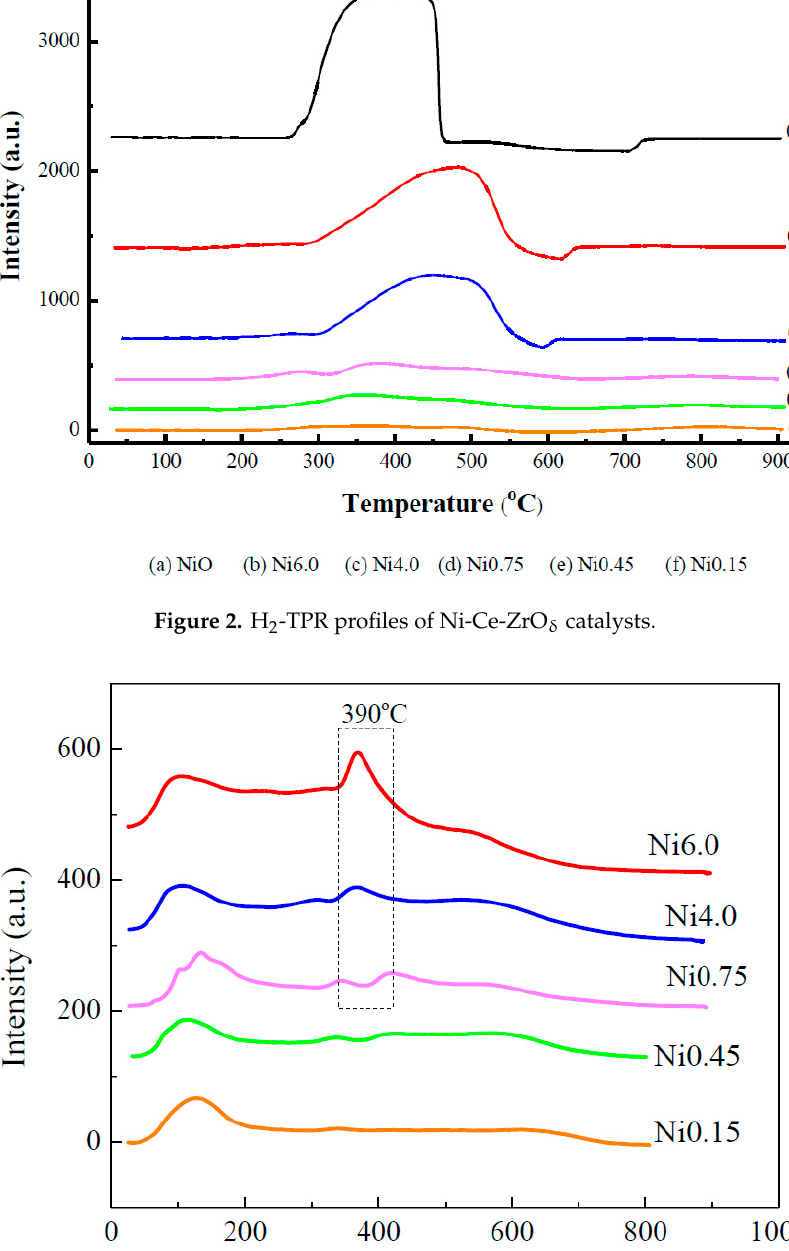
Figure 4. XPS spectra of Ni-Ce-ZrO δ catalysts; ( a ) O1s, ( b ) Ni2p, ( c ) Zr3d, and ( d ) Ce3d.